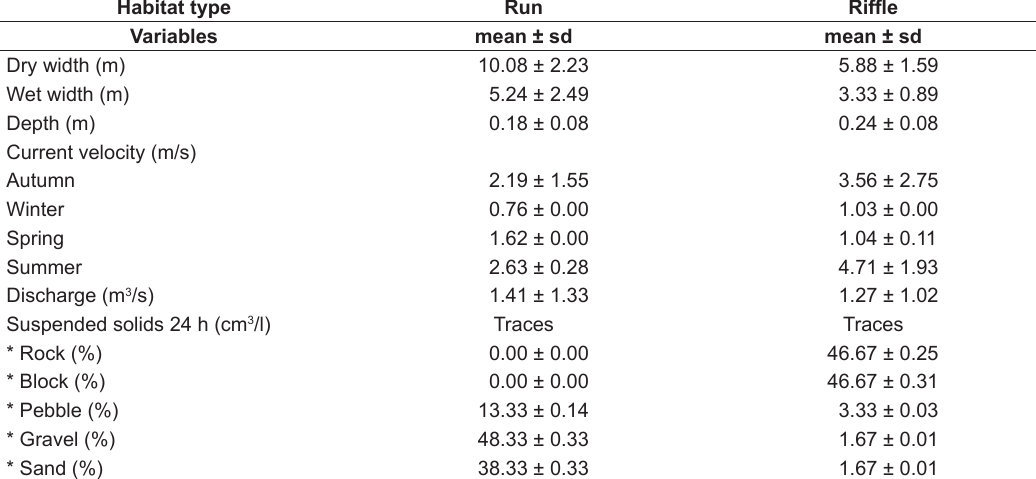
Table 1. Hydraulic and physical characteristics in run and riffle in Achiras stream (Córdoba, Argentina). * By Hynes